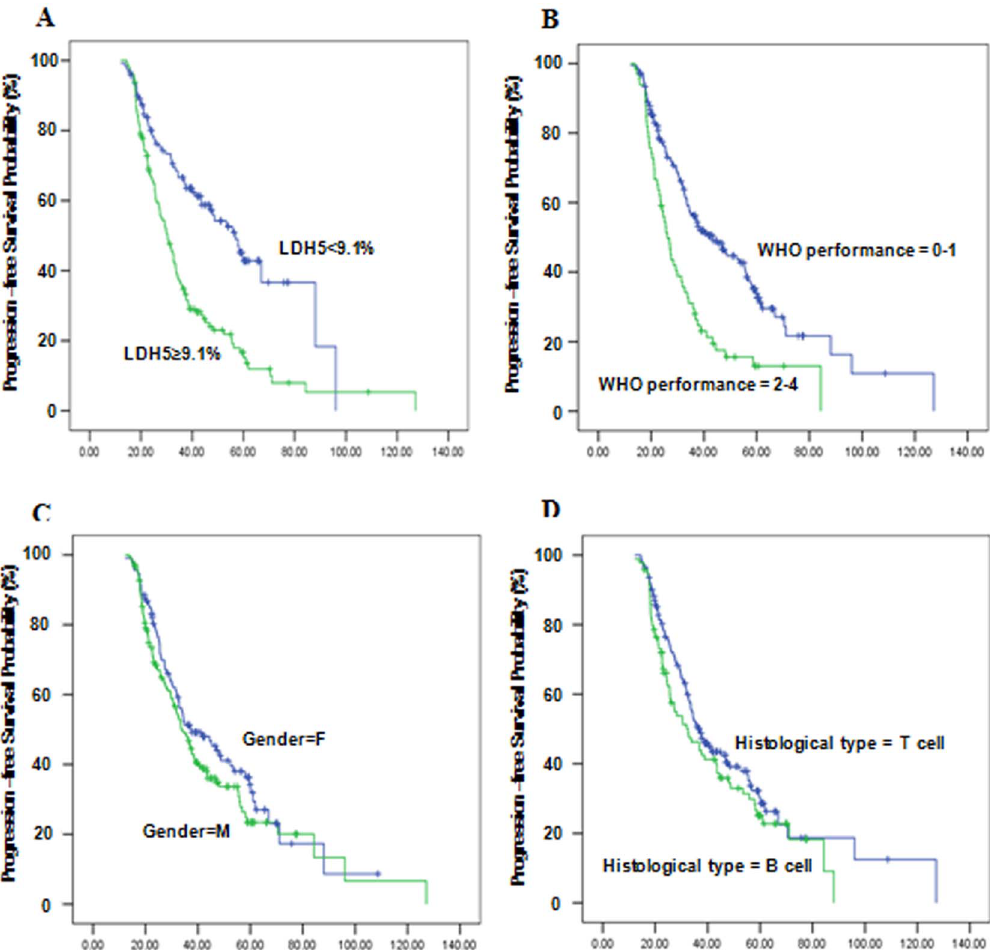
Figure 5. Kaplan-Meier progression-free survival curve associated with serum LDH-5 concentrations in 266 NHL patients. (A) The PFS probability of patients with elevated serum LDH-5 concentrations ( . 9.1%) was significantly lower than that of patients with normal concentrations (log-rank test, P , 0.001); (B) The worse WHO performance status (2–4) was also a significant unfavourable predictor for PFS ( P , 0.001); (C, D) The PFS was not associated with the gender and histological type of patients ( P= 0.199 and P= 0.153, respectively). PFS, progression-free survival.